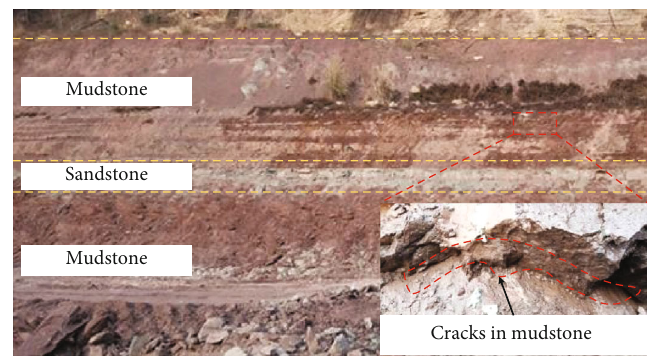
Figure 1: The red bed in Central